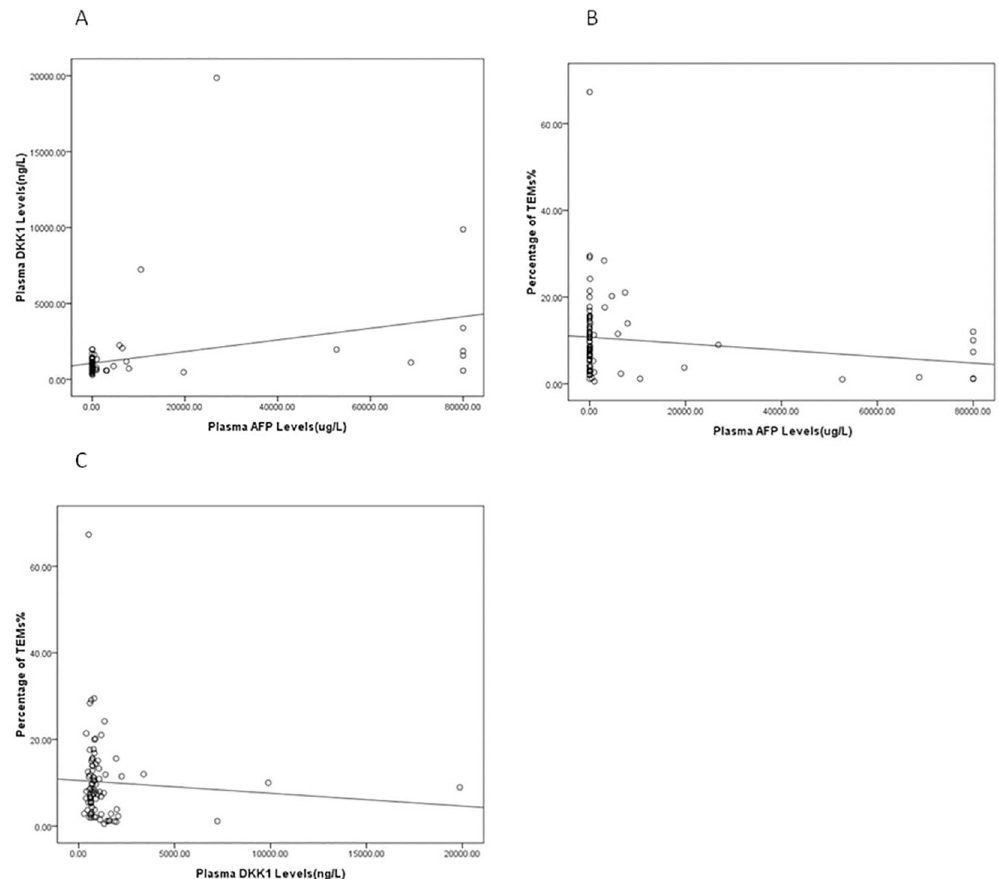
Fig 4. There were no or weak correlations between plasma DKK1, AFP and the percentage of TEMs. Correlationsbetweenthe percentage of TEMs, DKK1 and AFP were analyzedin 82 HCC patients. (A) Pearson’s analysisshows a low positive correlationbetweenplasma DKK1 and AFP(n = 82, P = 0.002, r = 0.332). (B) Pearson’sanalysisshows no correlationbetweenthe percentage of TEMs in peripheral CD14+CD16+ monocytes and AFP (n = 82, P = 0.129, r = -0.169). (C) Pearson’s analysisshows no correlation betweenthe percentageof TEMs in peripheral CD14+CD16+ monocytes and DKK1 (n = 82, P = 0.489, r =